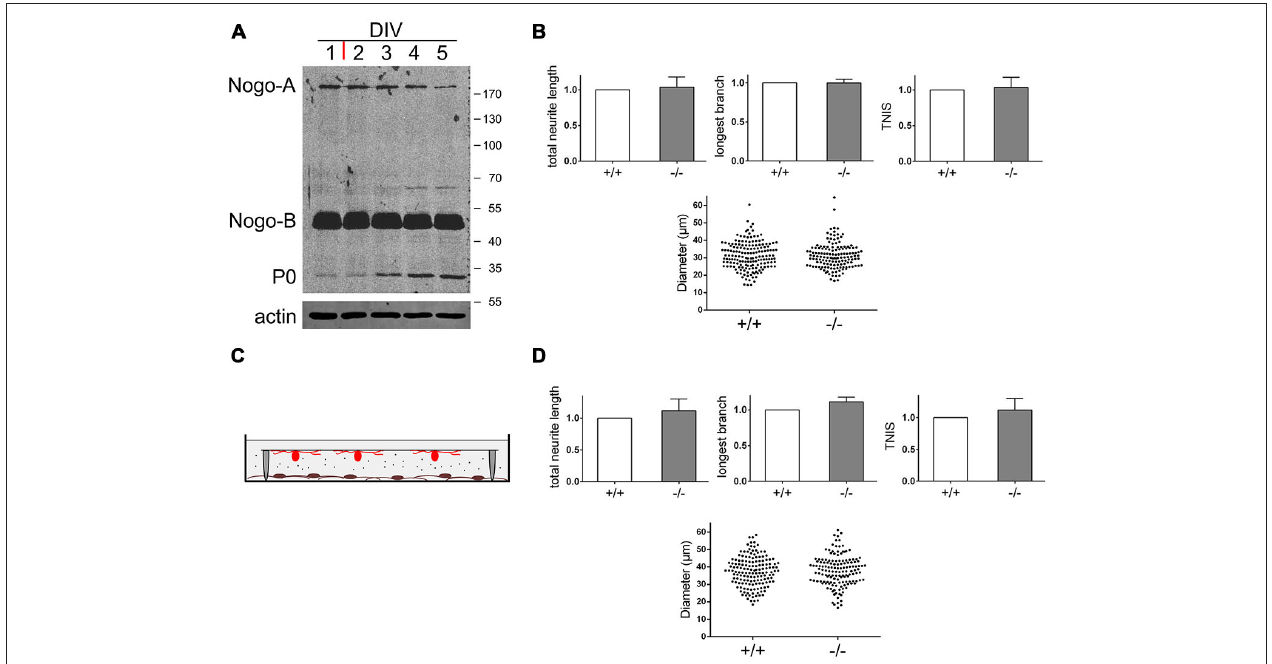
FIGURE 4 | Nogo-B’s effect on neuronal morphology depends on physical interaction with neurons and is restricted to undifferentiated Schwann cells. (A) Western blot of a time course experiment with Schwann cells pushed towards differentiation. At DIV1 serum free medium was added plus forskolin (red bar). Equal amounts of protein (45 µ g) were loaded in each lane. P0 serves as a differentiation marker, actin serves as a loading control. (B) Quantification of morphological parameters of adult wildtype sensory neurons grown on nogo + / + vs. nogo − / − Schwann cells. Sensory neurons were added at DIV4 to differentiating Schwann cells and the co-culture was fixed at DIV5. Five independent experiments were carried out with a total of 166 neurons being analyzed in the wildtype and 144 neurons in the knockout group. Morphological parameters were normalized to the wildtype control (set to 1.0) and expressed as mean ± SEM. P -values ≤ 0.05 are indicated. Neuronal cell body diameters are depicted in a dot blot. (C) Schematic of the indirect Schwann cell neuron co-culture lacking physical contact between the two cell types. Neurons were plated on a glass cover slip with paraffin feet attached and flipped face down onto the Schwann cell monolayer. (D) Quantification of morphological parameters of adult wildtype sensory neurons grown above nogo + / + vs. nogo − / − Schwann cells in an indirect co-culture. Five independent experiments were carried out with a total of 155 neurons being analyzed in the wildtype and 146 neurons in the knockout group. Morphological parameters were normalized to the wildtype control (set to 1.0) and expressed as mean ± SEM. P -values ≤ 0.05 are indicated. Neuronal cell body diameters are depicted in a dot blot.